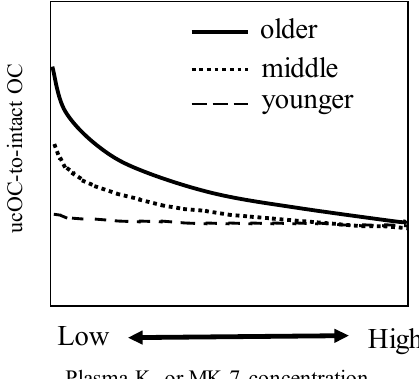
Figure 4. Relationship between plasma vitamin K 1 or menaquinone-7 (MK-7) levels and uncarboxylated osteocalcin (ucOC)-to-intact osteocalcin (OC) ratio according to age group. Older; >= 70 years old, middle; 50–69 years old, younger; 30–49 years old (adapted from reference [15]).